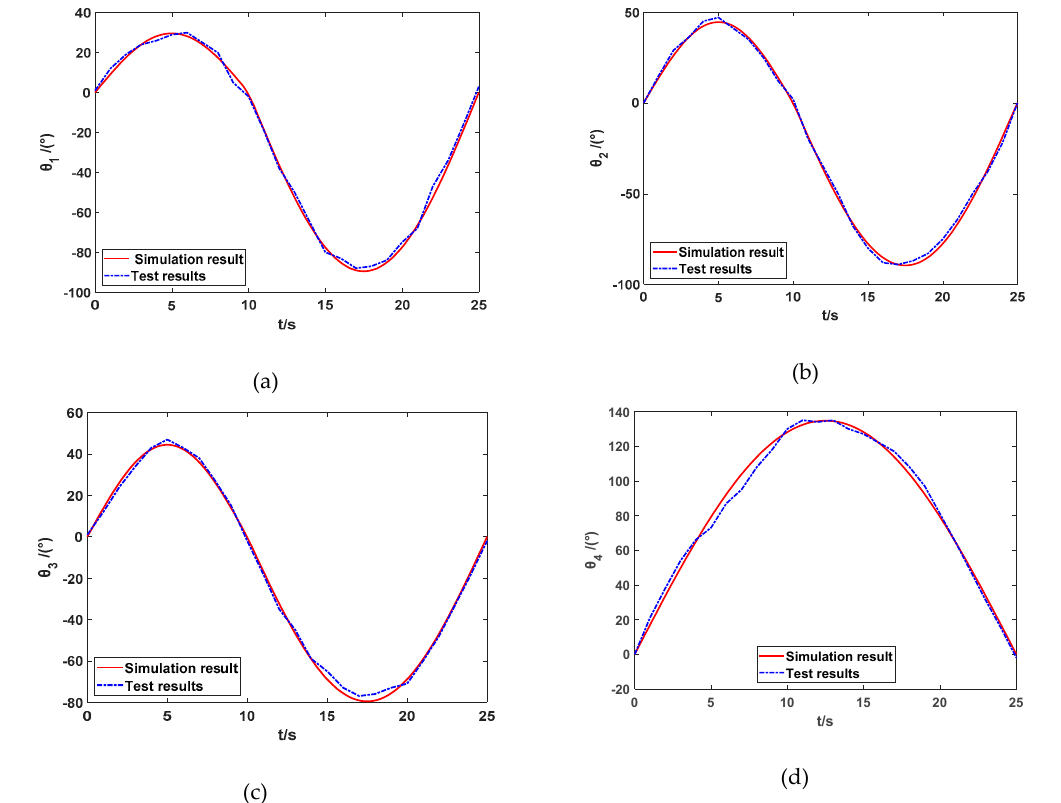
Figure 14. Tracking results of wearable upper limb rehabilitation robot. ( a ) Shoulder flexion / extension; ( b ) shoulder abduction / adduction; ( c ) shoulder internal / external rotation; ( d ) elbow flexion /